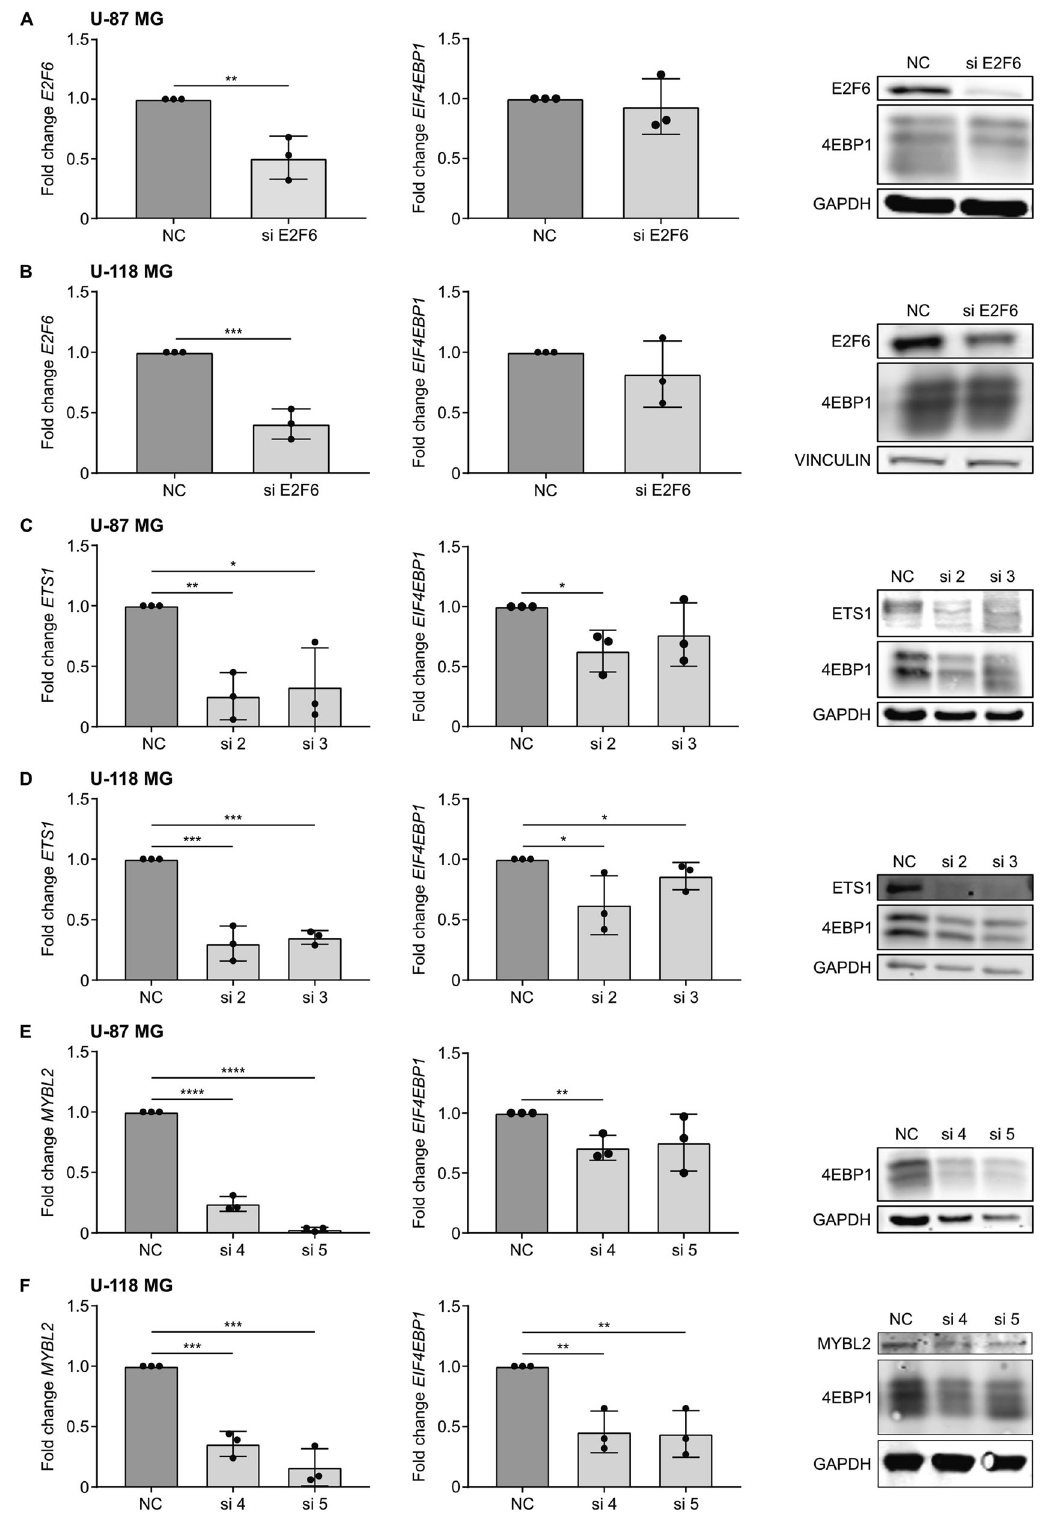
Fig. 4 Regulation of EIF4EBP1 mRNA and protein expression by MYBL2 and ETS1 in glioblastoma cells. A – F U-118 MG and U-87 MG glioblastoma cells were transiently transfected with negative control siRNAs (NC), and an siRNA pool targeting ( A , B ) E2F6 (si E2F6) or two different siRNAs each targeting either ( C , D ) ETS1 (si 2 and si 3) or ( E , F ) MYBL2 (si 4 and si 5). Cells were re-transfected after 96 h with their corresponding siRNA and incubated for a total of 192 h. MRNA and protein were harvested to determine the expression levels of EIF4EBP1 / 4EBP1 and ( A , B ) E2F6, ( C , D ) ETS1 or ( E , F ) MYBL2 by qRT-PCR and immunoblots. Data obtained by qRT-PCR represent the mean of three independent replicates ±SD and the fold change in expression was normalized to the negative control. Results of representative immunoblot are depicted on the right-hand side of the diagrams representing the qRT-PCR results. Signi fi cance was calculated using an unpaired and one- tailed parametric t -test (* p < 0.05, ** p < 0.01, *** p < 0.001, **** p < 0.0001). Cell Death Discovery (2022)